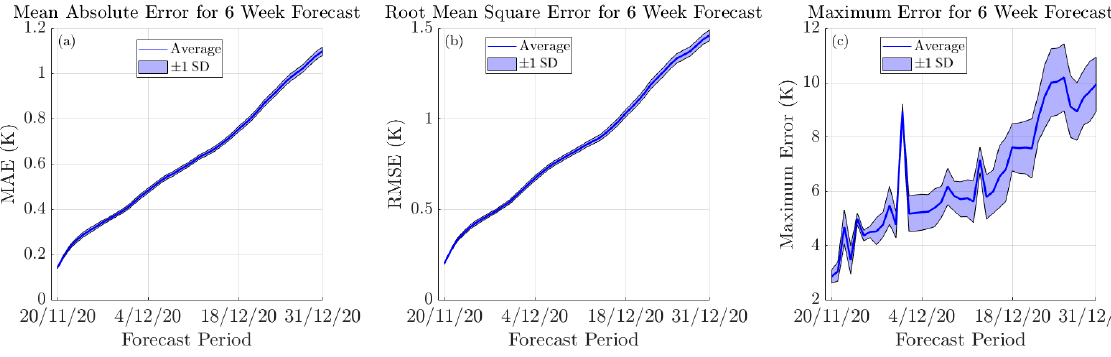
Figure 9. The evolution of the error for the 6-week forecast. The average model error statistics are plotted each day as well as ± 1 standard deviation. The mean absolute error in the forecast over the entire ocean is depicted in panel (a) , the root-mean-square error is shown in panel (b) and the maximum error is presented in panel (c)